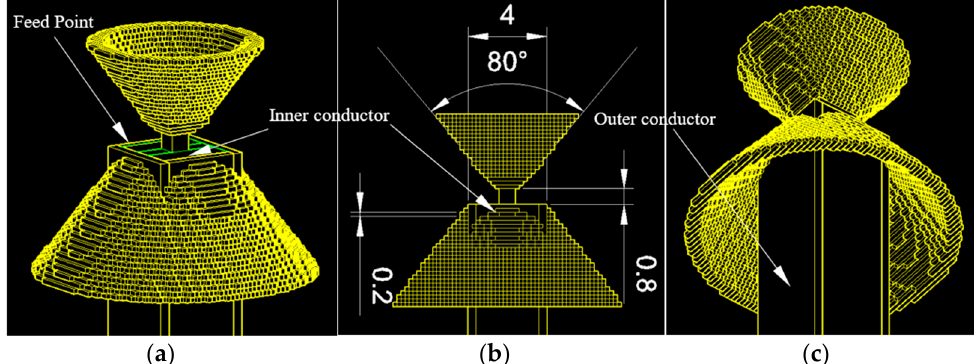
Figure 3. ( a ) An isometric view close to the antenna feeding point (from an upper looking angle), yellow and green colors indicate metal and dielectric material; ( b ) the front-view and dimensions in mm; ( c ) another isometric view from a lower looking angle.